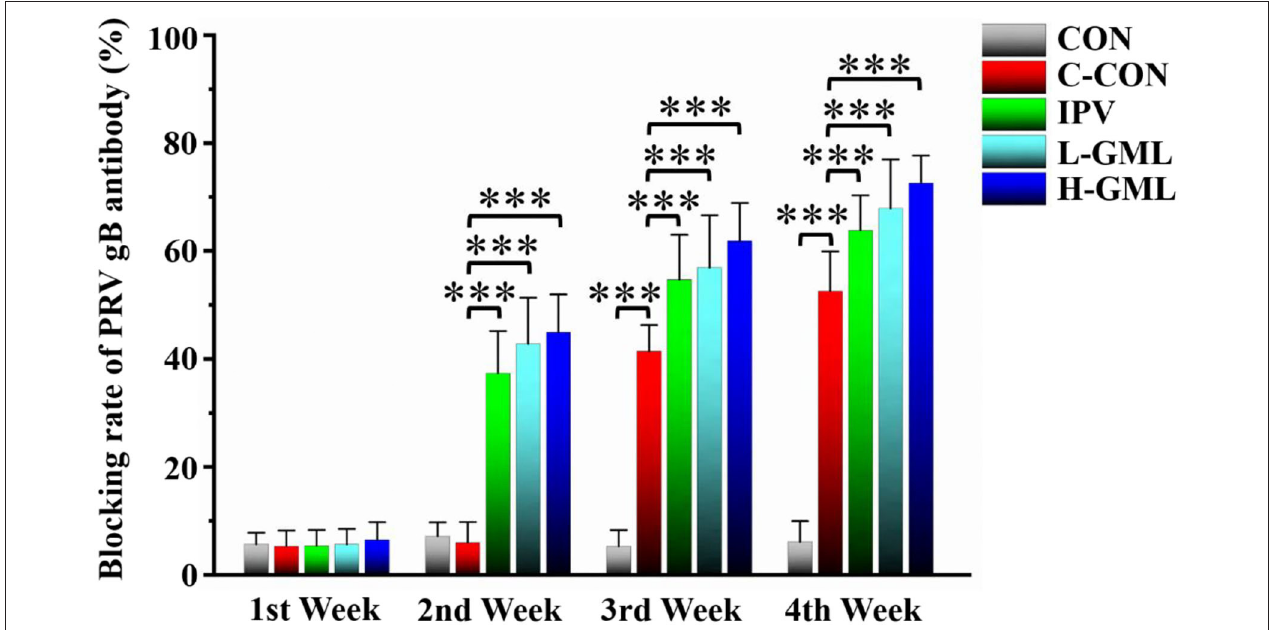
FIGURE 1 | Pseudorabies virus glycoprotein B (PRV gB) antibody levels in serum of experimental pigs. The results are presented as mean ± SD. Dissimilar numbers of stars represent significant differences (*: p < 0.05, **: p < 0.01, ***: p <